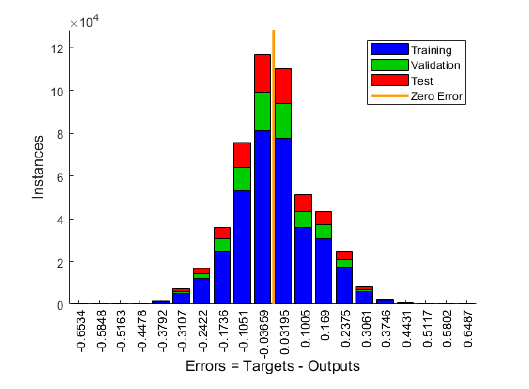
Figure 3. Error histogram for the training, validation, and testing data set.